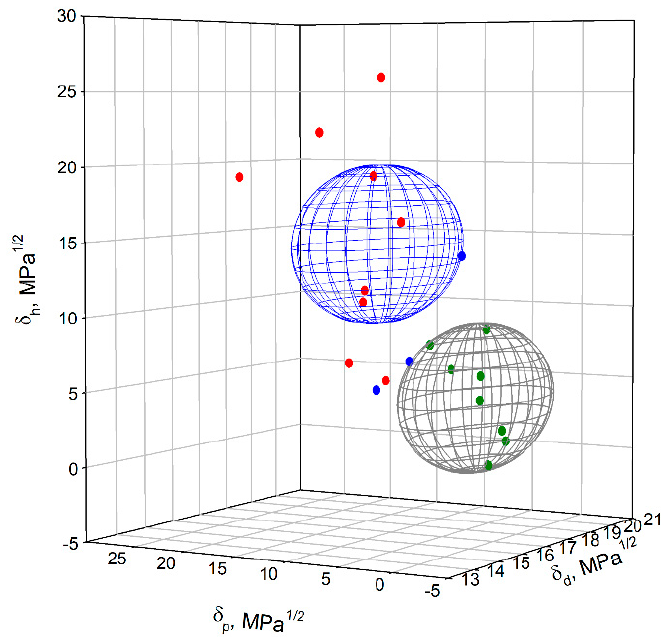
Figure 2. Hansen space for SBR (gray sphere) and BNNTs (blue sphere). Good solvents for SBR are represented with green dots, intermediate solvents are represented with blue dots, and bad solvents are represented with red dots.